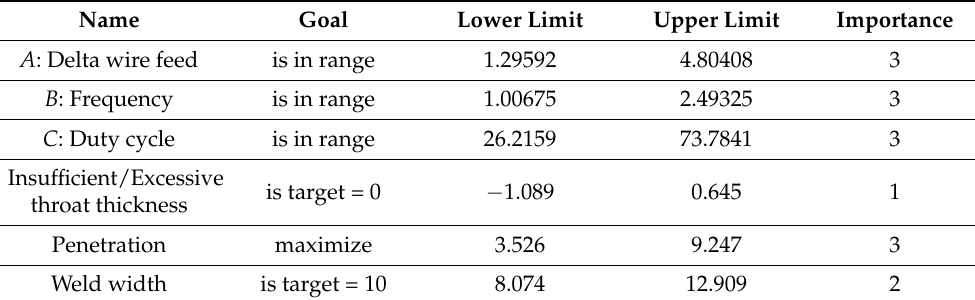
Table 14. Defined limitations for optimization of parameters.